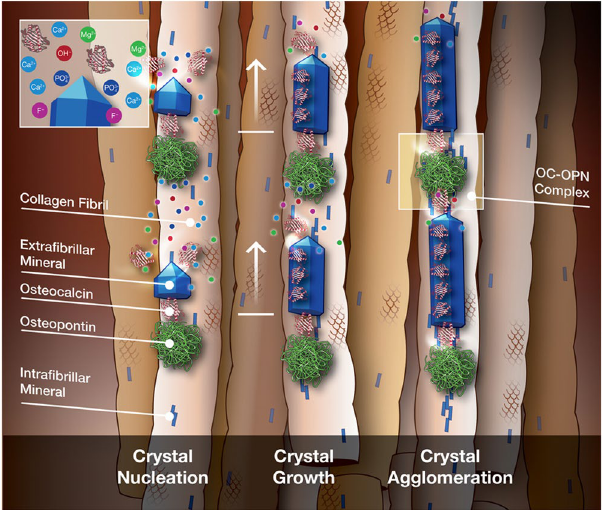
Figure 5. Mechanism of biomolecular regulation of mineral in bone. Crystals nucleate (left) under the cooperative action of OC and OPN, and possibly other NCPs. The highly charged OPN aids in the recruitment of essential ionic groups and charged trace elements. Proteoglycans or ion-transport mechanisms may also be responsible for such a recruitment process. OC regulates crystal growth (center) along the long axis of collagen, by attaching at favorable crystallographic locations on the growing crystal. Finally, crystals agglomerate with each other through the formation of OC-OPN linkages, when they arrive at another nucleation site. (Image credits: Mark Esposito,